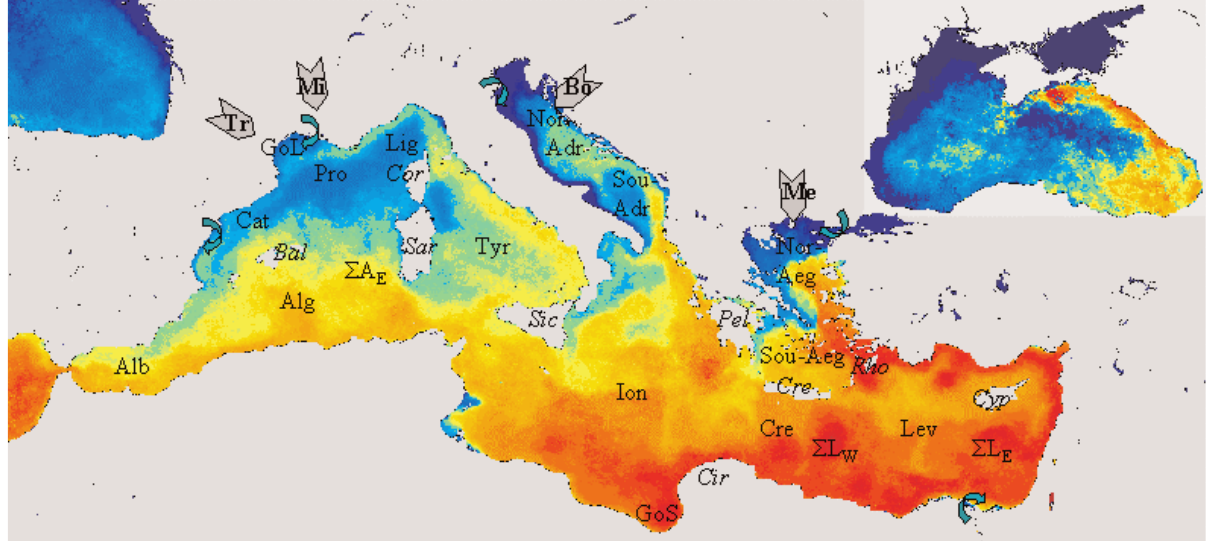
shape of the isotherms, gradients, etc.) are, from place to place, exactly as measured on a given day (i.e. a few-minute passage) during the considered period. See text for comments and abbreviations (from Millot and Taupier-Letage,